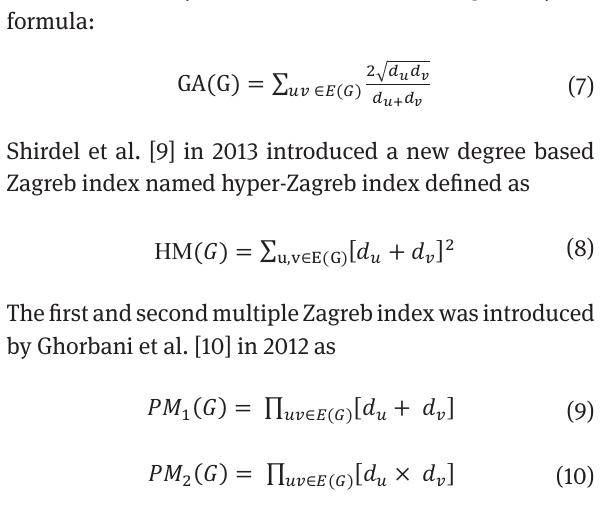
Table 1: Edge partition of nanosheet H [m,n] based on the degree of end vertices of each